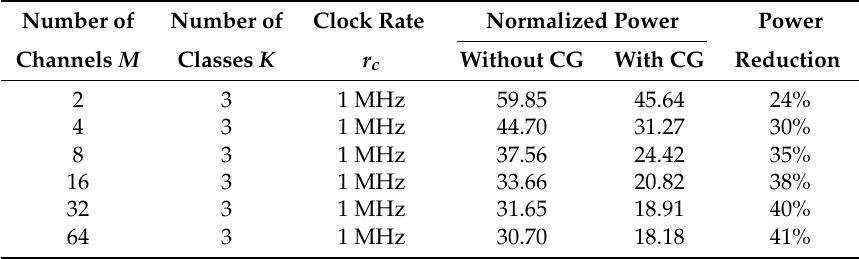
Table 6. The normalized power consumption per channel ( µ W/channel) of the proposed circuit for various numbers of channels M .